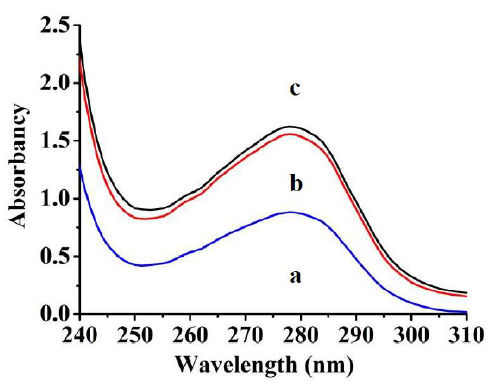
Figure 7. Adsorption of serum proteins on ( a ) MIP; and ( b ) NIP at 278 nm. Curve ( c ) is of bovine serum (diluted with 20 times volume of water).